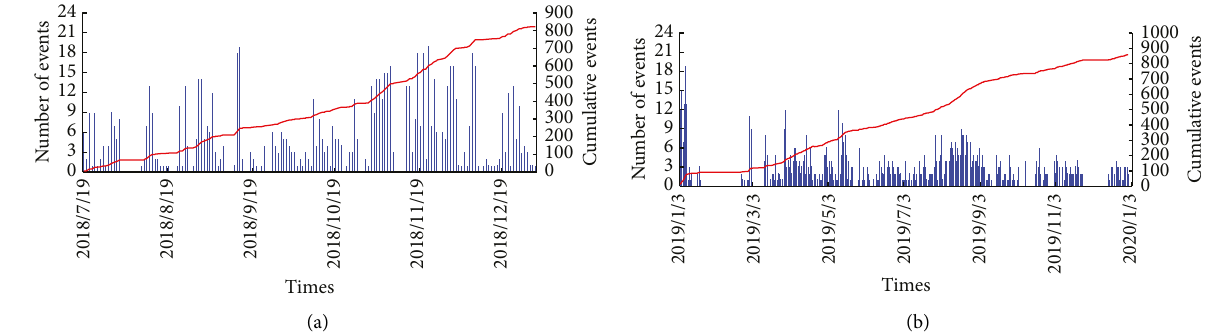
Figure 8: Time distribution of microseismic events in the main powerhouse. (a) In 2018. (b) In 2019.